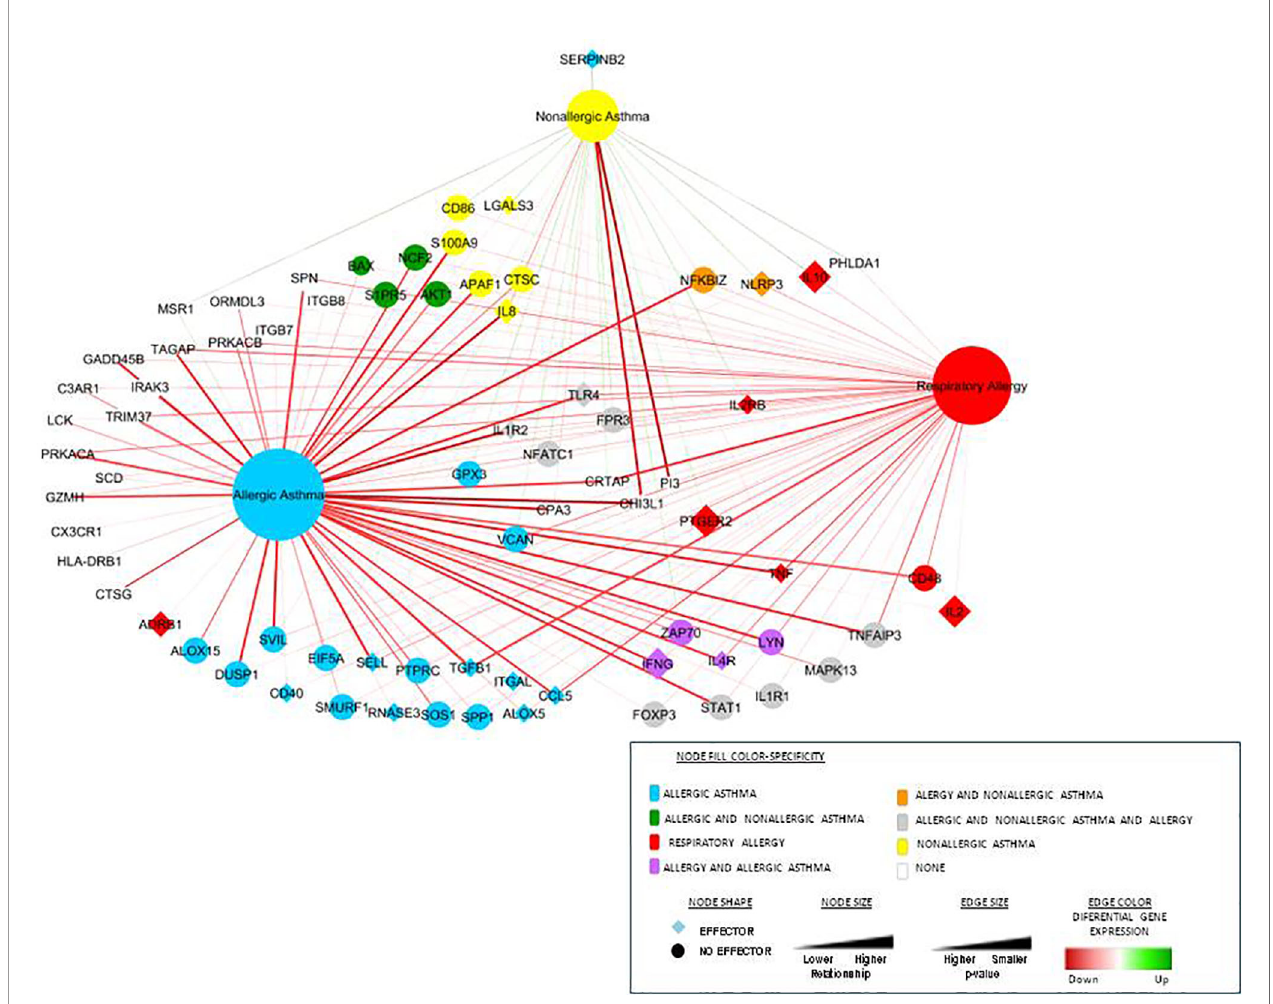
FIGURE 3 | Representation of the three diseases and their connections combined with the differential gene-expression proteins obtained from our experimental data. This network includes connections between the diseases (the three main nodes) and the most differential gene-expression proteins obtained from our experimental data (27, 28). The node shape illustrates whether the protein is an effector or not, color represents speci fi city and size and the level of relationship. Differential gene expression is represented by the edge color and the p -value by the